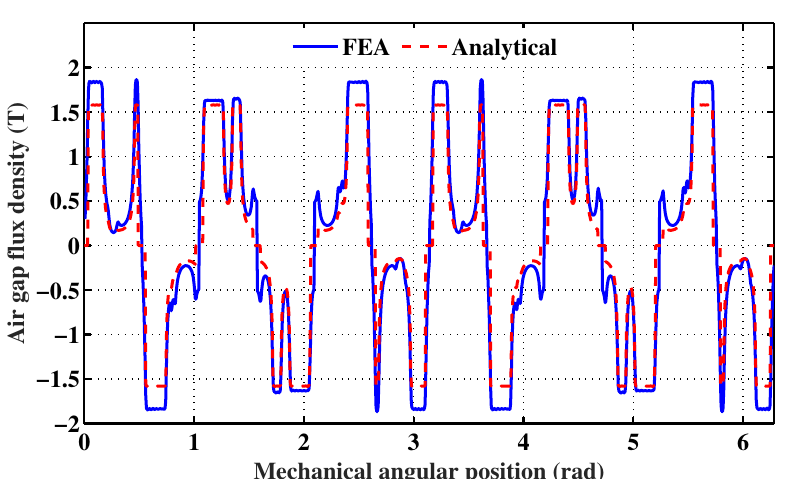
Figure 5. PM flux density spatial repartition with the stator and rotor slotting effects taken into